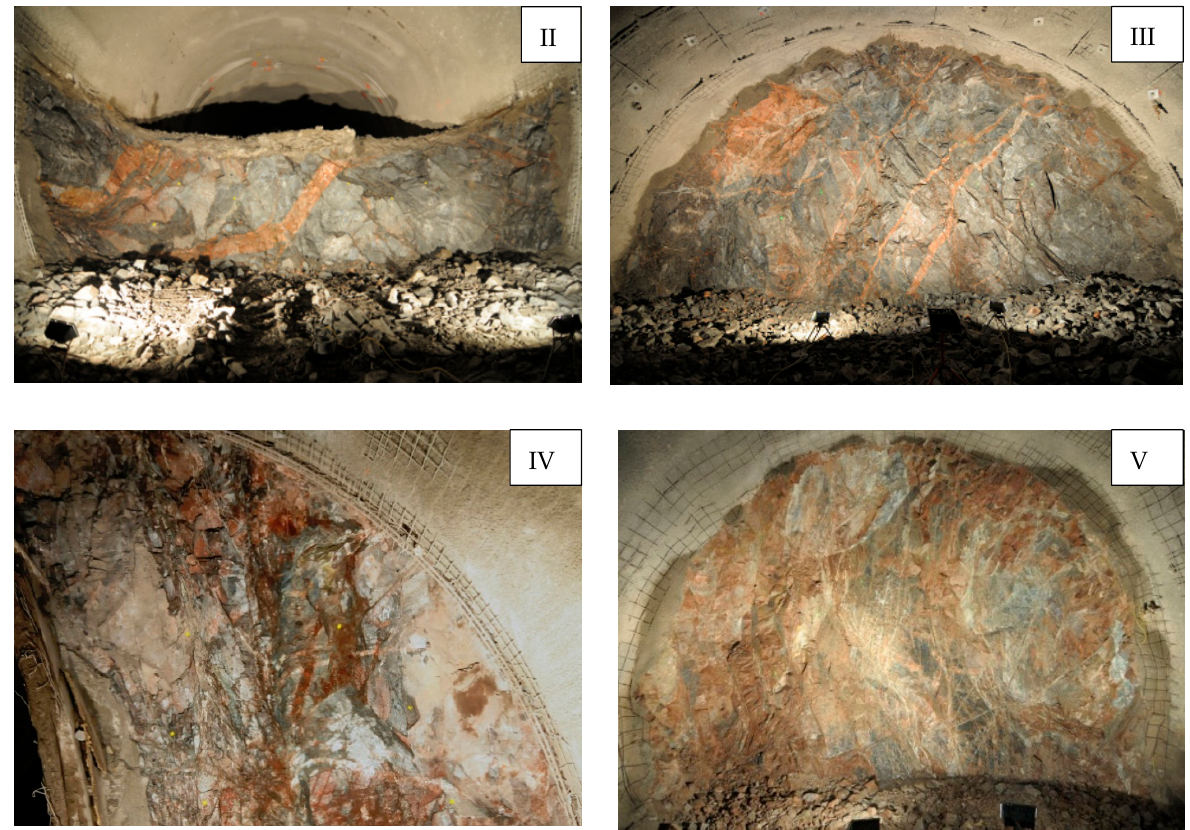
Figure 3. Examples of rock mass classes in various tunnel sections: Chamber bench ~ 60 m 2 (class II ), Chamber top heading ~ 60 m 2 (class III ), Chamber half top heading 30 m 2 (class IV ), Research tunnel 33 m 2 (class V ) (granitic rocks, Bátaapáti, Hungary).